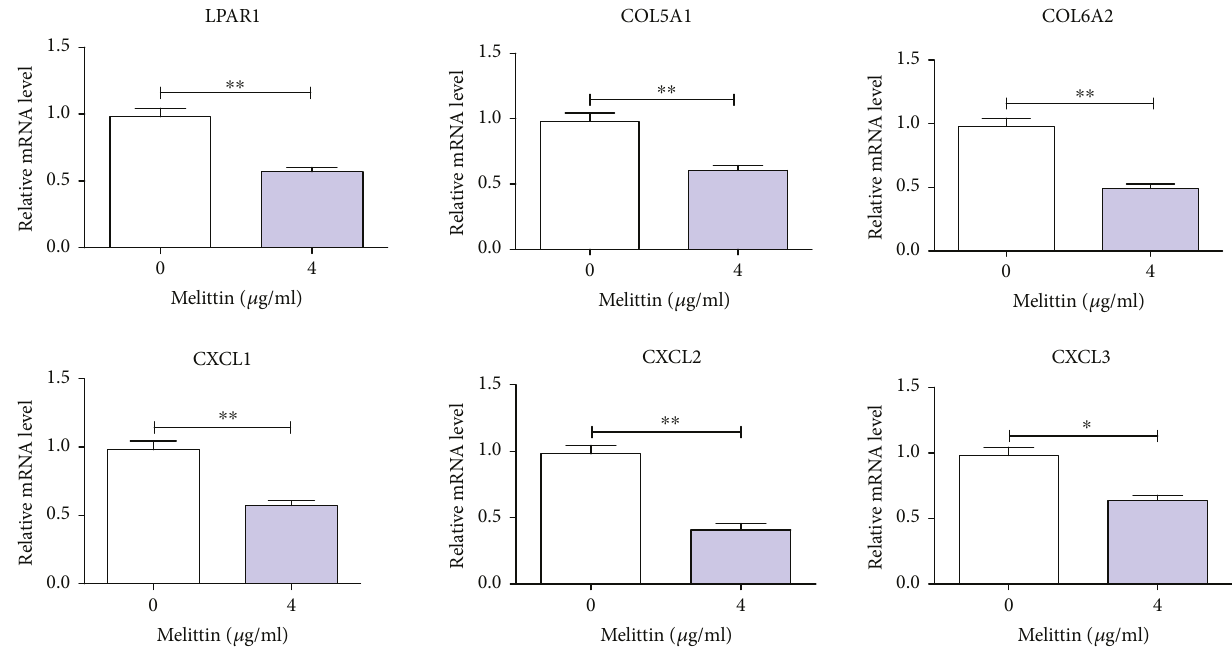
Figure 6: The expressions of the module-related DEGs associated with PI3K-Akt and TNF signaling pathways were detected in T24 cells treated with melittin by qRT-PCR. DEGs: di ff erentially expressed genes. ∗ P < 0 05 and ∗∗ P < 0 01